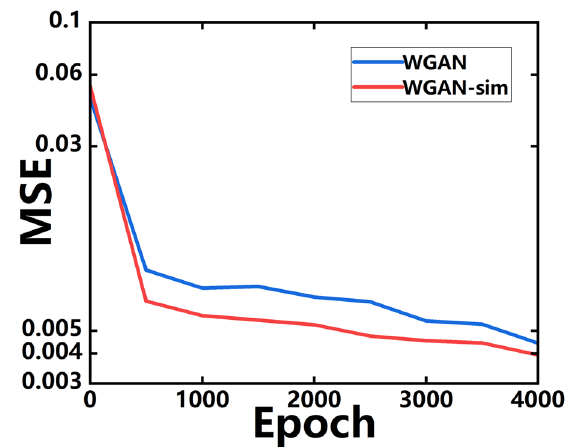
Figure 5. The MSE curves of responses between the target and the generated devices by WGAN (blue line) and WGAN-sim (red line) models. The target responses are from devices in the mini-validation set.